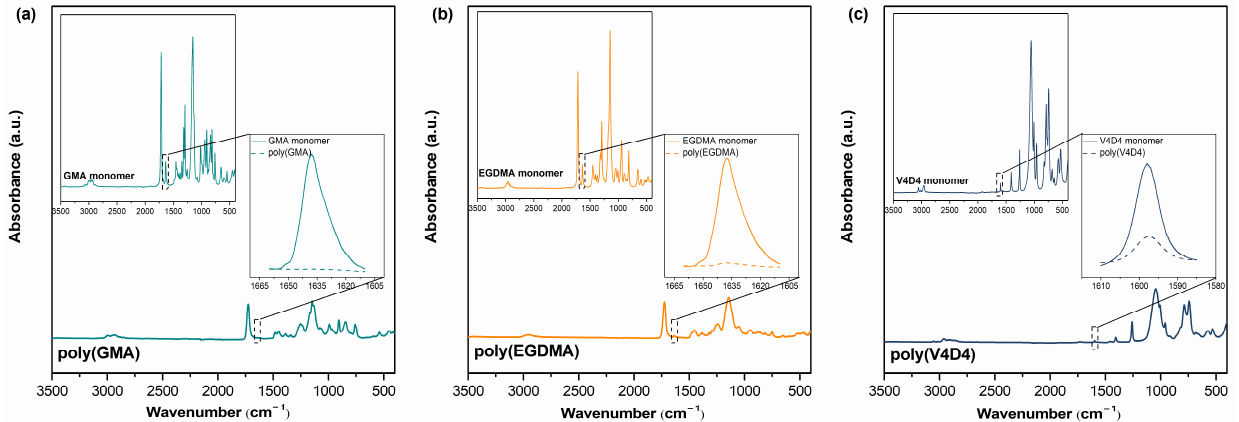
Figure 2. FTIR spectra of ( a ) GMA (green), ( b ) EGDMA (orange) and ( c ) V4D4 (blue) monomers and their polymers.